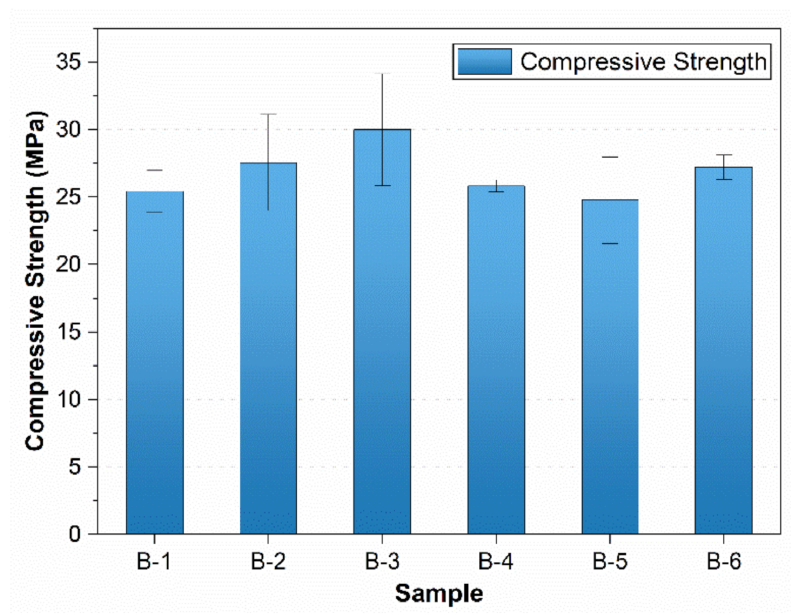
Figure 2. Compressive strength of waste mask-incorporated concrete at 28 days.